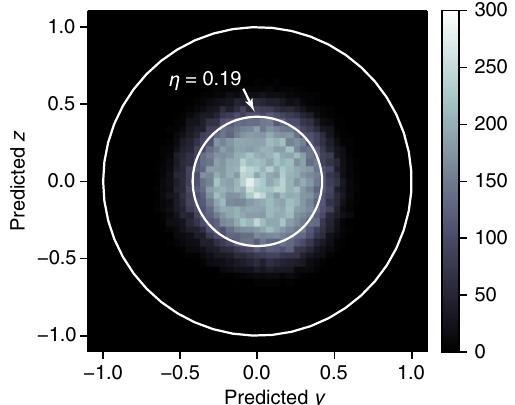
FIG. 8. Trajectory histogram for a fast Rabi drive 2 Ω = κ ¼ 2 . 0 , postselected for steady state (times longer than Γ − 1 circle is a prediction for the purity of individual trajectories from Eq. (E6) with η calibrated from Appendix J.